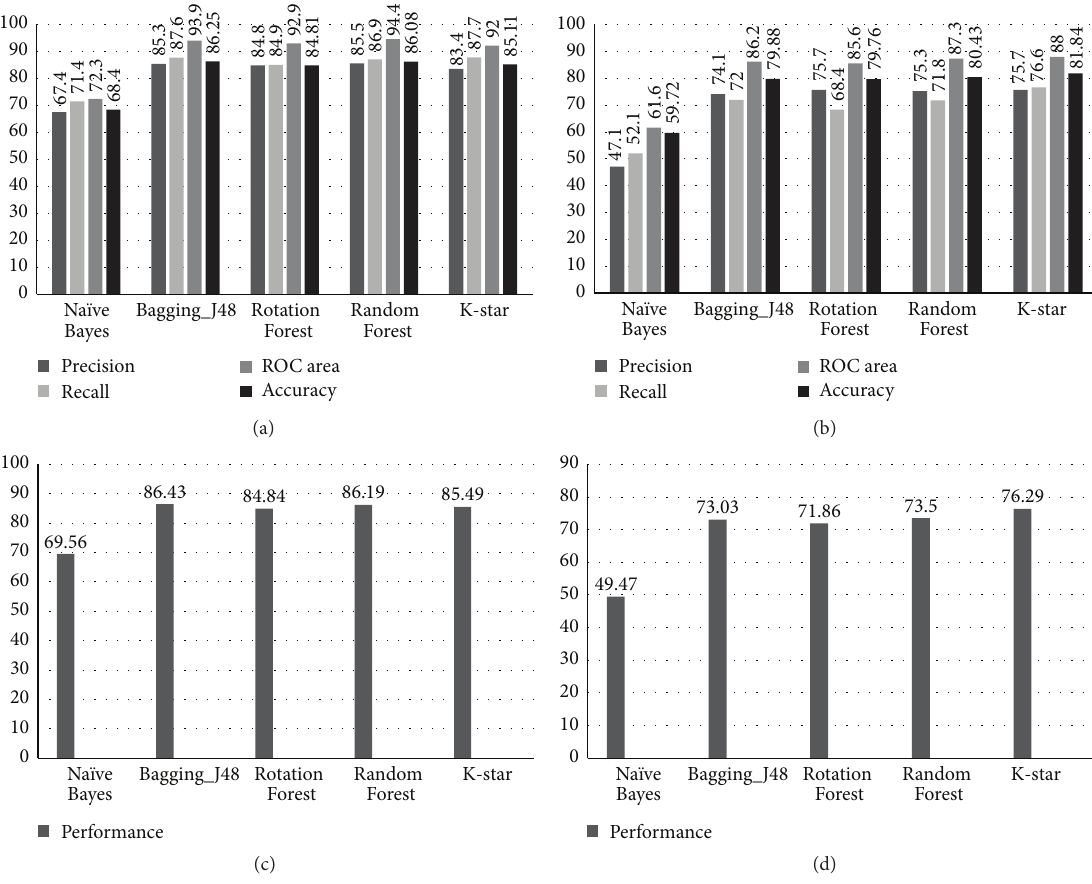
Figure 2: (a) Comparative representation of the performance metrics of five models for their predictions on the training dataset. (b) Comparative representation of the performance metrics of five models for their predictions on the test dataset. (c) Comparison of performance/ 𝐹 -score values for five models on training set. (d) Comparison of performance/ 𝐹 -score values for five models on test